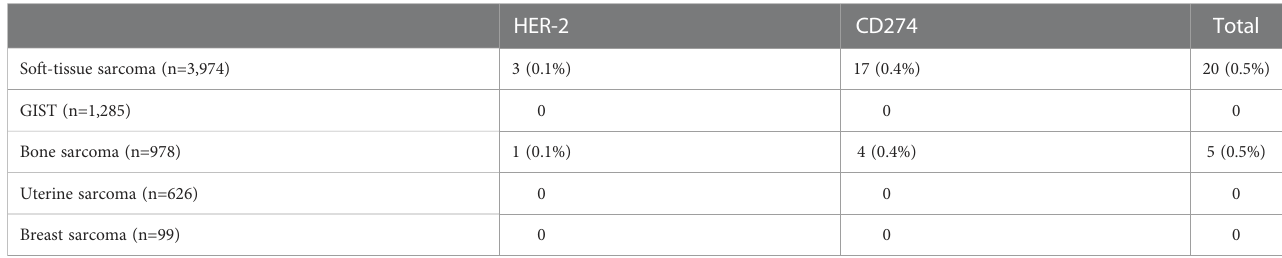
TABLE 5 Prevalence of gene ampli fi cations being investigated as potential histology-agnostic predictive biomarkers in sarcoma samples in the AACR GENIE